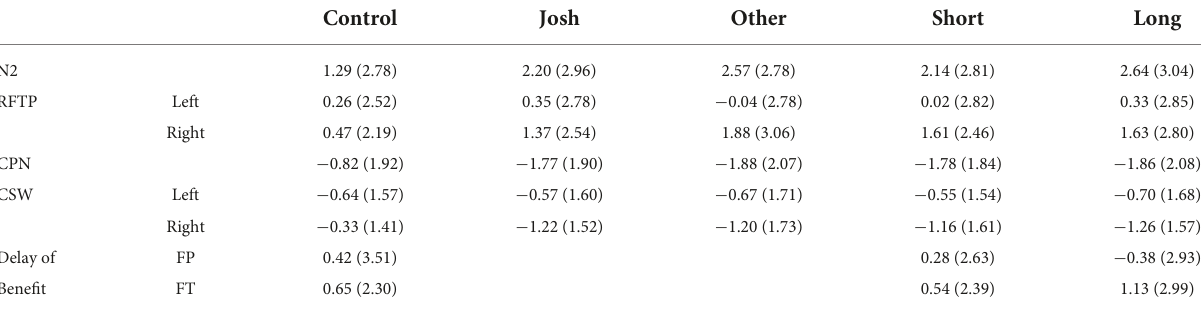
TABLE 2 Mean and standard deviation of voltage in microvolts for effects of Benefactor and Delay of Reward for modulations of the ERPs that were sensitive to ethical decision-making.